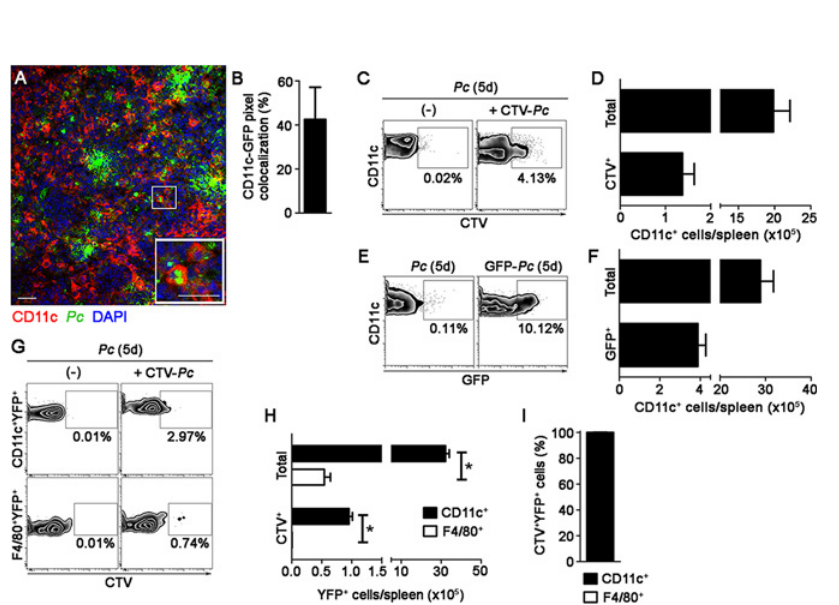
Figure 6. Ex vivo analysis of iRBC uptake by splenic DCs during pre-crisis. (A and B) B6 mice were i.p. infected with 1 × 10 6 GFP- Pc iRBCs. Spleens were analyzed after five days, at a time of day when mature parasite stages predominated. (A) A representative immunofluorescence image (10x magnification) represents the spleens of GFP- Pc -infected mice. The lower panel details a merged GFP + CD11c + cell. (B) Percentage of CD11c pixels colocalized with GFP pixels in the immunofluorescence images is shown (mean ± SD). (C and D) B6 mice were i.p. infected with 1 × 10 6 Pc iRBCs. At five days p.i., half of the B6 mice were i.v. re-infected with 1 × 10 8 mature CTV- Pc iRBCs. Spleens were analyzed by flow cytometry after 15 min. (C) Representative contour plots show CTV staining in the CD11c + cells of Pc -infected mice that were re-infected or not with CTV- Pc iRBCs. CD11c + cells in the CD3 - CD19 - DX5 - Ter119 - cell population were analyzed. Data show the percentages of CTV + cells in the CD11c + cell population. (D) Numbers of total and CTV + CD11c + cells per spleen in re-infected mice were calculated from the data obtained in C (means ± SD). (E and F) B6 mice were i.p. infected with 1 × 10 6 Pc iRBCs or GFP- Pc iRBCs. Spleens were analyzed after five days, at a time of day when mature parasite stages predominated. (E) Representative contour plots obtained by flow cytometry show GFP staining in the CD11c + cells of mice that were infected with Pc iRBCs or GFP- Pc iRBCs. CD11c + cells in the CD3 - CD19 - DX5 - Ter119 - cell population were analyzed. Data show the percentages of GFP + cells in the CD11c + cell population. (F) Numbers of total and GFP + CD11c + cells per spleen in GFP- Pc -infected mice were calculated from the data obtained in E . (G - I) B6.CD11c-YFP mice were i.p. infected with 1 × 10 6 Pc iRBCs. At five days p.i., half of the B6.CD11c-YFP mice were i.v. re-infected with 1 × 10 8 mature CTV- Pc iRBCs. Spleens were analyzed by flow cytometry after 15 min. (G) Representative contours plots show CTV staining in the CD11c + YFP + and F4/80 + YFP + cells. Data show the percentages of CTV + cells in each population. (H) The numbers of total and CTV + CD11c + YFP + and F4/80 + YFP + cells per spleen were calculated from the data obtained in G (means ± SD). (I) The relative proportions of CD11c + and F4/80 + cells in the CTV + YFP + cell population were calculated from the data obtained in H (means ± SD). In A , the scale bars correspond to 50 µ m. In B , data were calculated using FIJI software. In H , significant differences (p < 0.05) between the indicated groups are designated by * . In A-I , one representative experiment out of three (n = 3-4) is